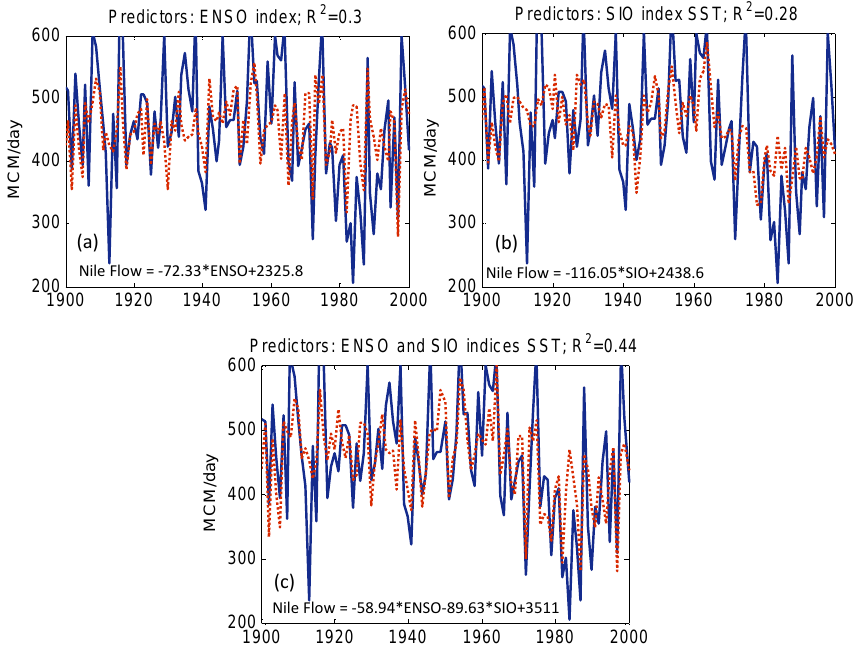
Figure 4. Observed (solid blue lines) and simulated (dashed red lines) average Nile flows in million cubic meters per day (MCMday − 1 ) from July to October at Dongola using the (a) ENSO index, the (b) SIO index and the (c) ENSO and SIO indices as predictors for the period 1900 to 2000. The simulated flows are calculated based on the equations shown in each figure, in which the predictands are the average observed SSTs over the ENSO and SIO regions in degrees Celsius and the predictor is the average Nile flow from July to October in million cubic meters per day (MCMday − 1 ).